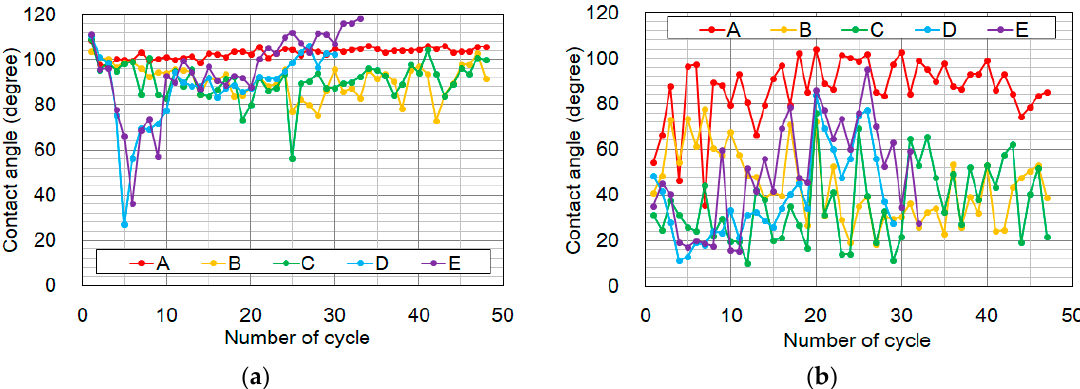
Figure 3. Change in contact angle with number of cycles in 50-cycle test with gap spacing 2 mm. ( a ) Just before commencement of voltage application. ( b ) Just after voltage interruption.